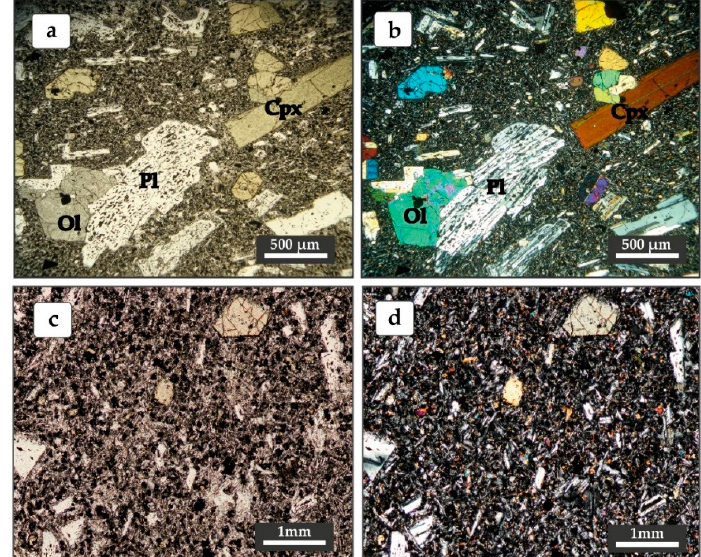
Figure 3. Petrography of the Etnean basaltic bedrock (sample AC1R2, Acireale site). Phenocrysts include plagioclase, clinopyroxene and olivine ( a ) observation in plane-polarized light ( b ) observation with crossed polarizers. Isotropic intergranular microtexure of the groundmass observations ( c ) in plane-polarized light ( d ) and with crossed polarizers. Pl = plagioclase; Ol = Oivine; Cpx = clinopyroxene.